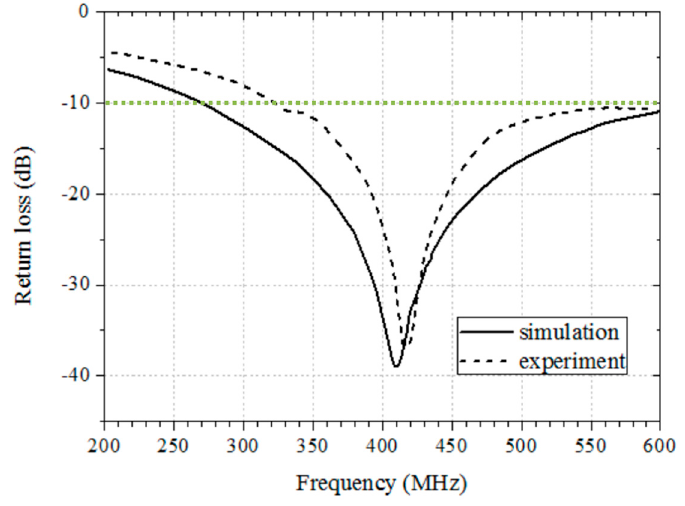
Figure 19. Reflection coefficient frequency responses with respect to frequency.